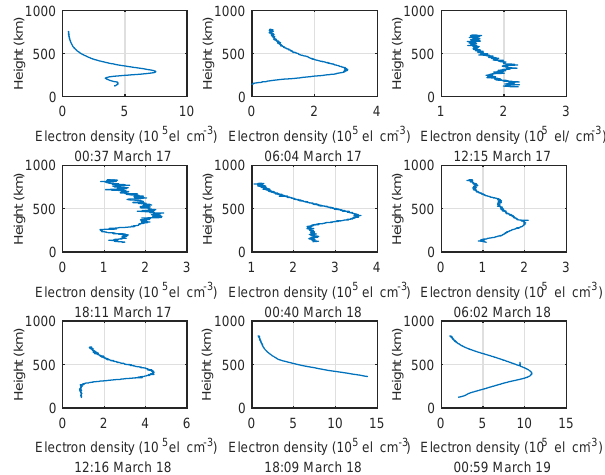
Figure 13. The profiles of ionospheric electron density during the different periods of the geomagnetic